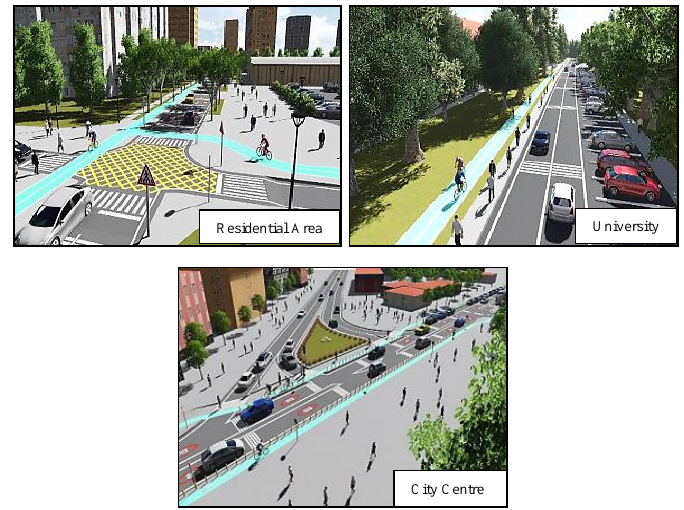
Figure 3. The Turkish locations as they might look in Avoid Vision.